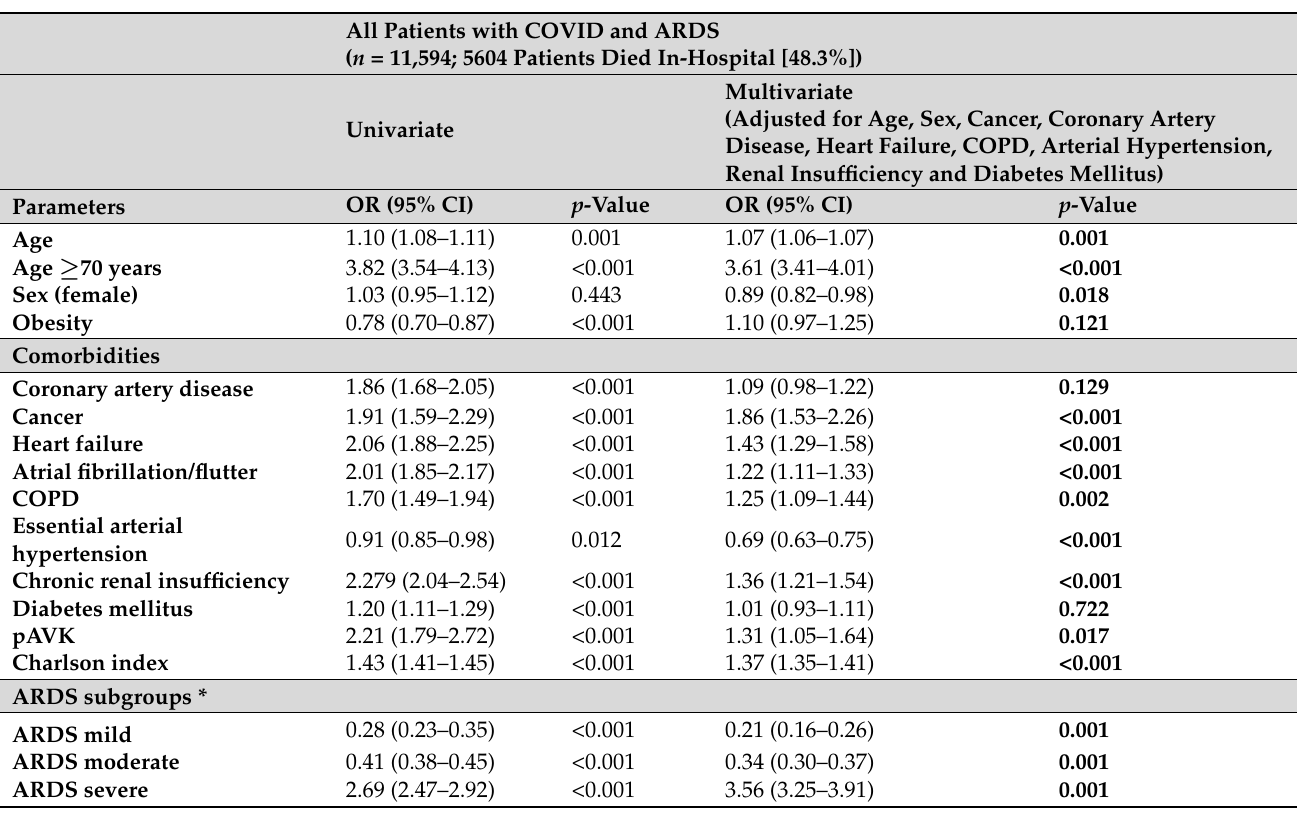
Table 3. Impact of baseline characteristics, comorbidities, clinical presentation and complications on in-hospital case